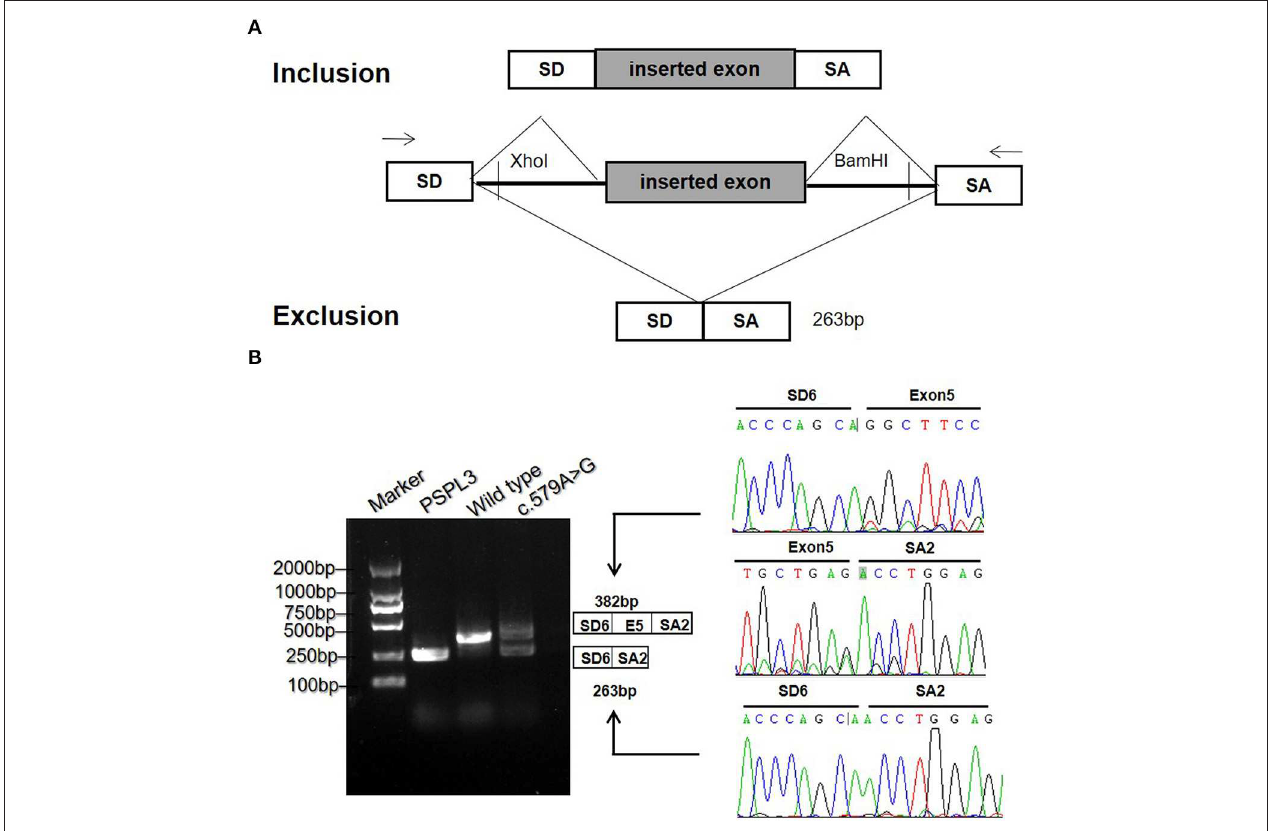
FIGURE 3 | The minigene splicing assay in vitro for the synonymous variant c.579A > G based on the pSPL3 exon trapping vector. (A) The pSPL3 vector contains 2 exons SD and SA, and a functional intron. All of the indicated fragments were separately cloned into the XhoI and BamHI cloning sites of the pSPL3 vector. SD6 and SA2 primers were designed for RT-PCR amplification of cDNA sequences generated by transfected HEK293T cells. (B) Electrophoresis and sequencing of RT-PCR products of wild type and mutant c.579A > G allele observed two species of RNA compared to one product for the wild type allele. The lower fragment resulted from the c.579A > G allele lost the exon